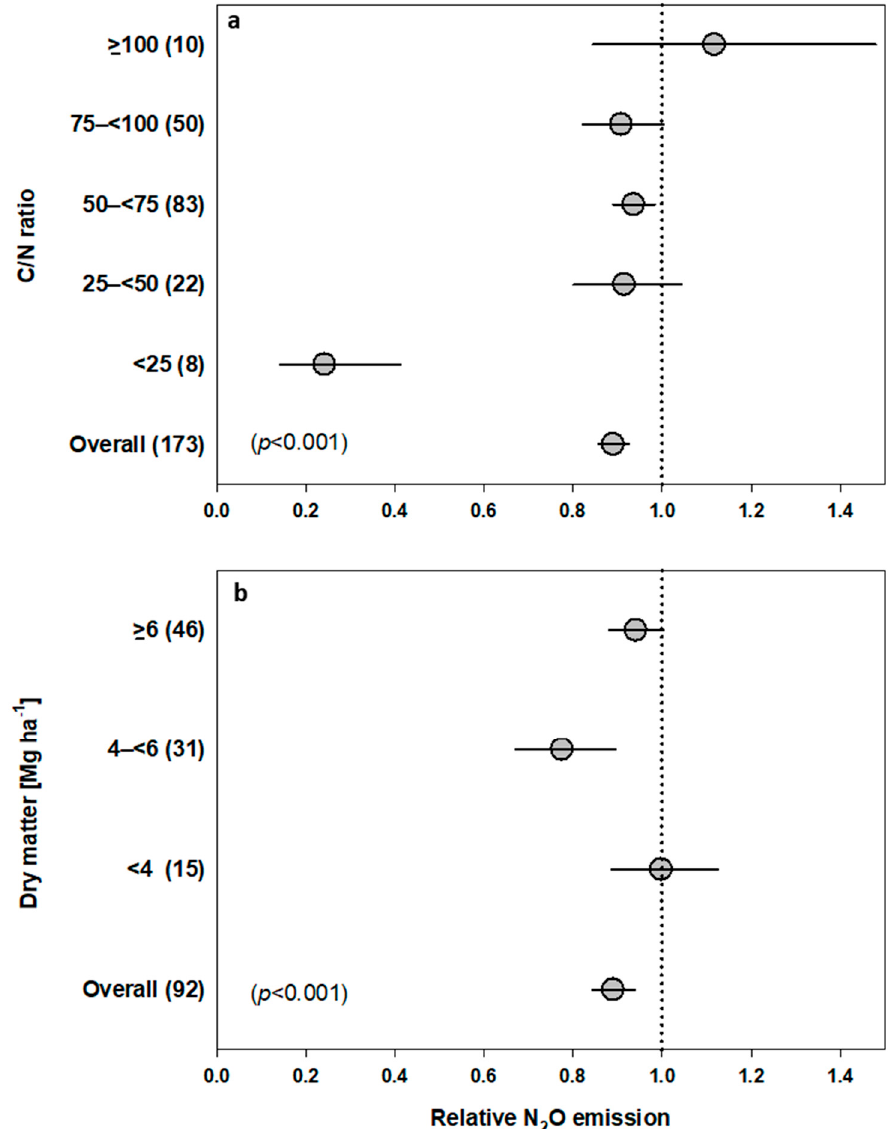
Figure 3. The effect crop residue removal on N 2 O emissions as affected by C/N-ratio ( a ) and quantity of aboveground crop residues ( b ). N 2 O emissions from control treatments with crop residues = 1. Mean effect sizes (circle) and 95% confidence intervals (CIs, error bars) are shown. The number of observations is given in parentheses.